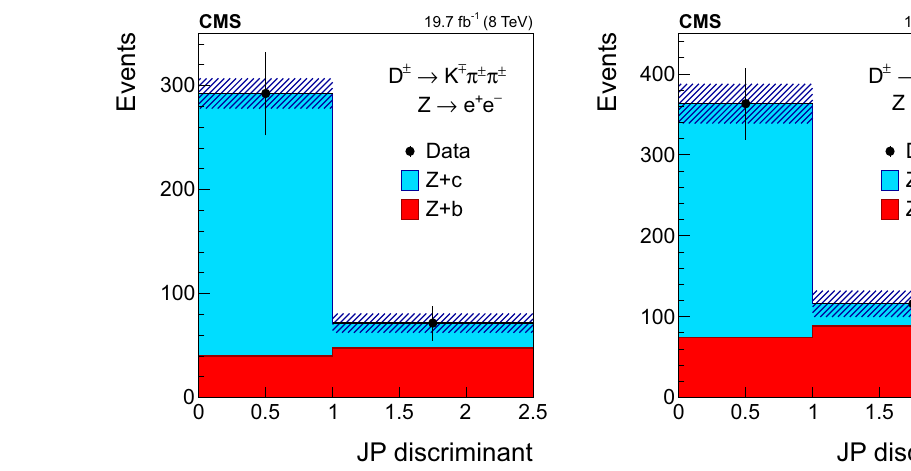
data points represent the statistical uncertainty in the data. The hatched areas represent the sum in quadrature of the statistical uncertainties of the templates describing the two contributions (Z + c from W + c data events and Z + b from simulation)